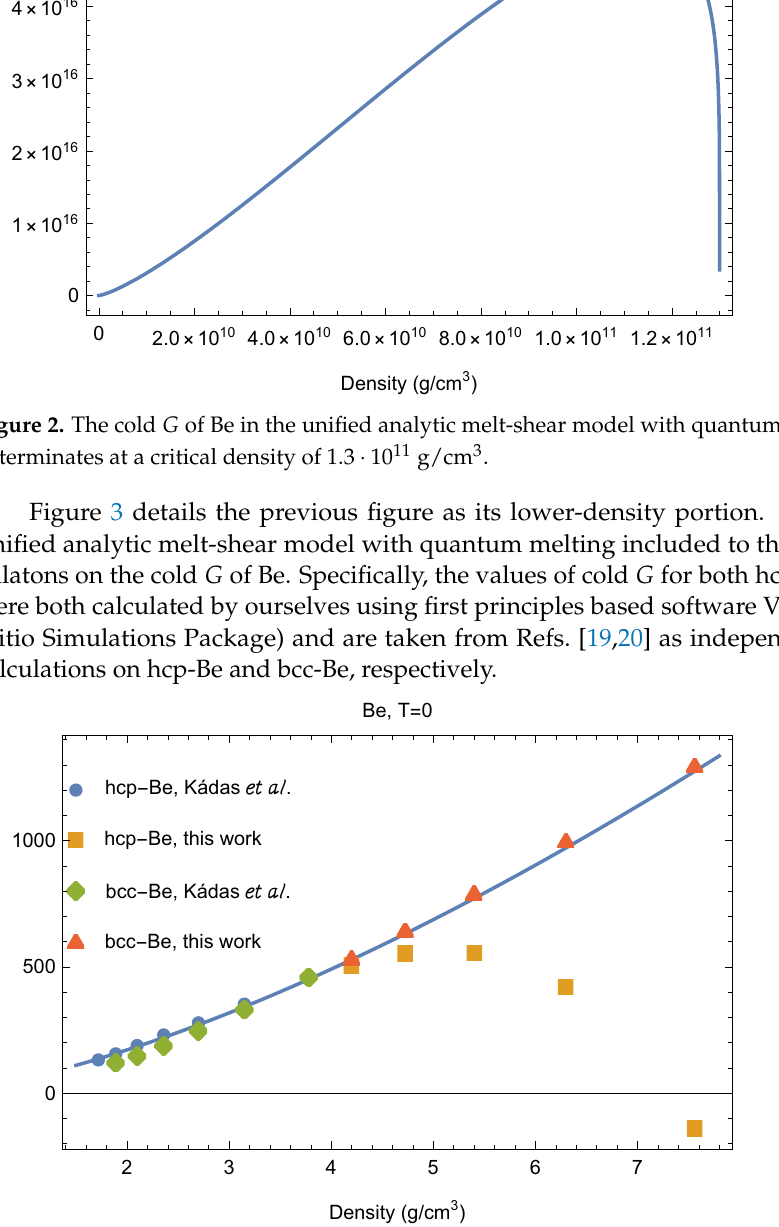
Figure 3. The lower-density portion of Figure 2: the cold G of Be in the unified analytic melt-shear model with quantum melting included (blue curve) vs. the theoretical caluclations described in the